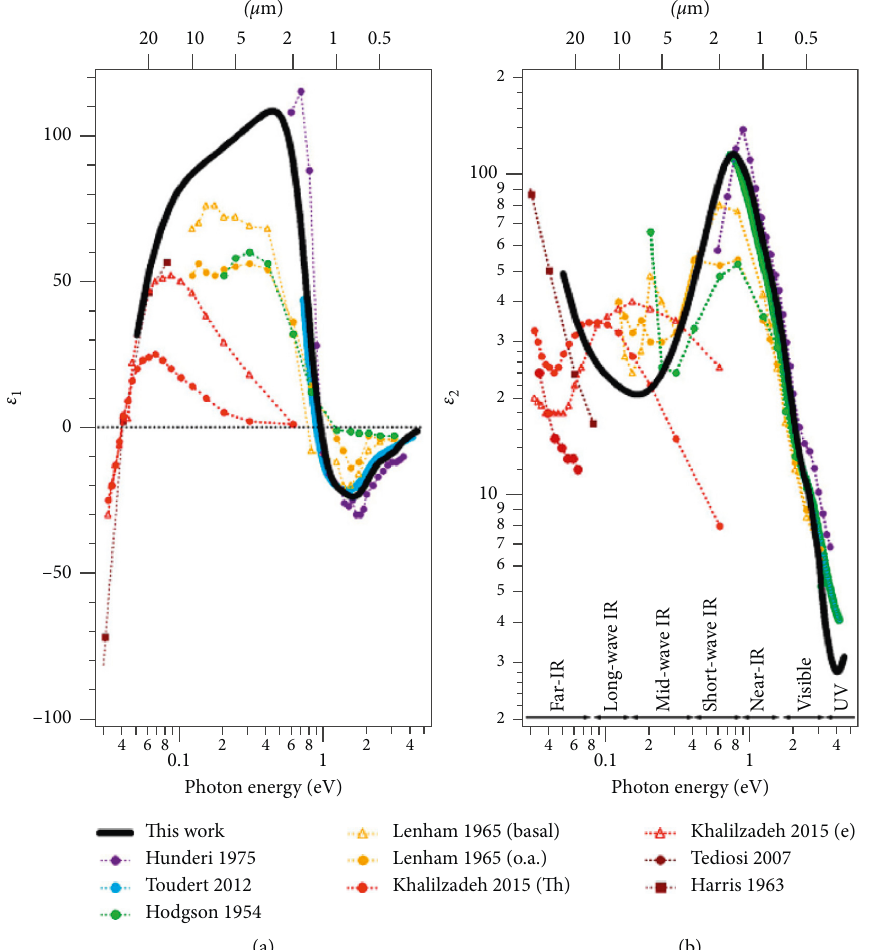
Figure 2: Broadband dielectric function ( ε � ε 1 + iε 2 , black) of bulk Bi together with literature data, showing their broad dispersion. The origin of these data and the reasons behind their dispersion (mostly in relation with the sample quality) are discussed in [34, 35]. Reprinted with permission from American Chemical